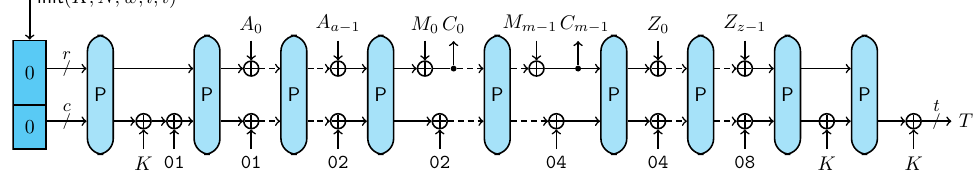
Figure 6: NORX v3.0 serial